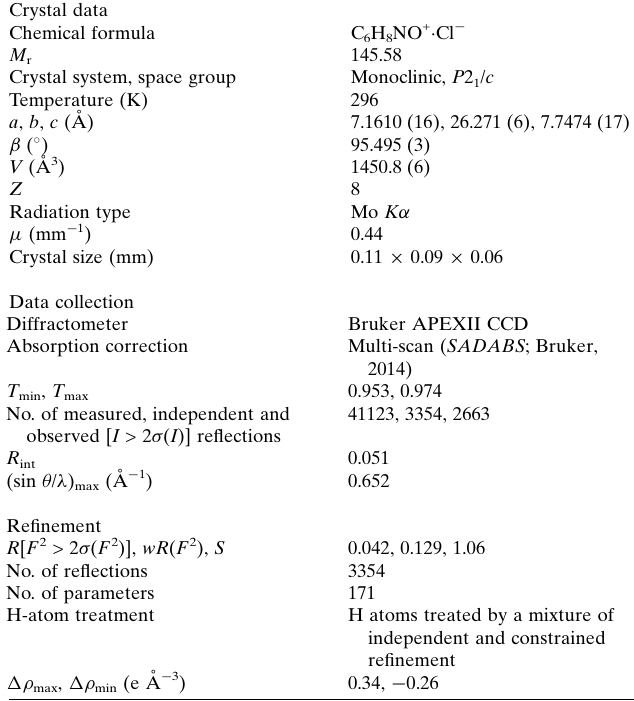
Table 2 Experimental details. Crystal data Chemical formula